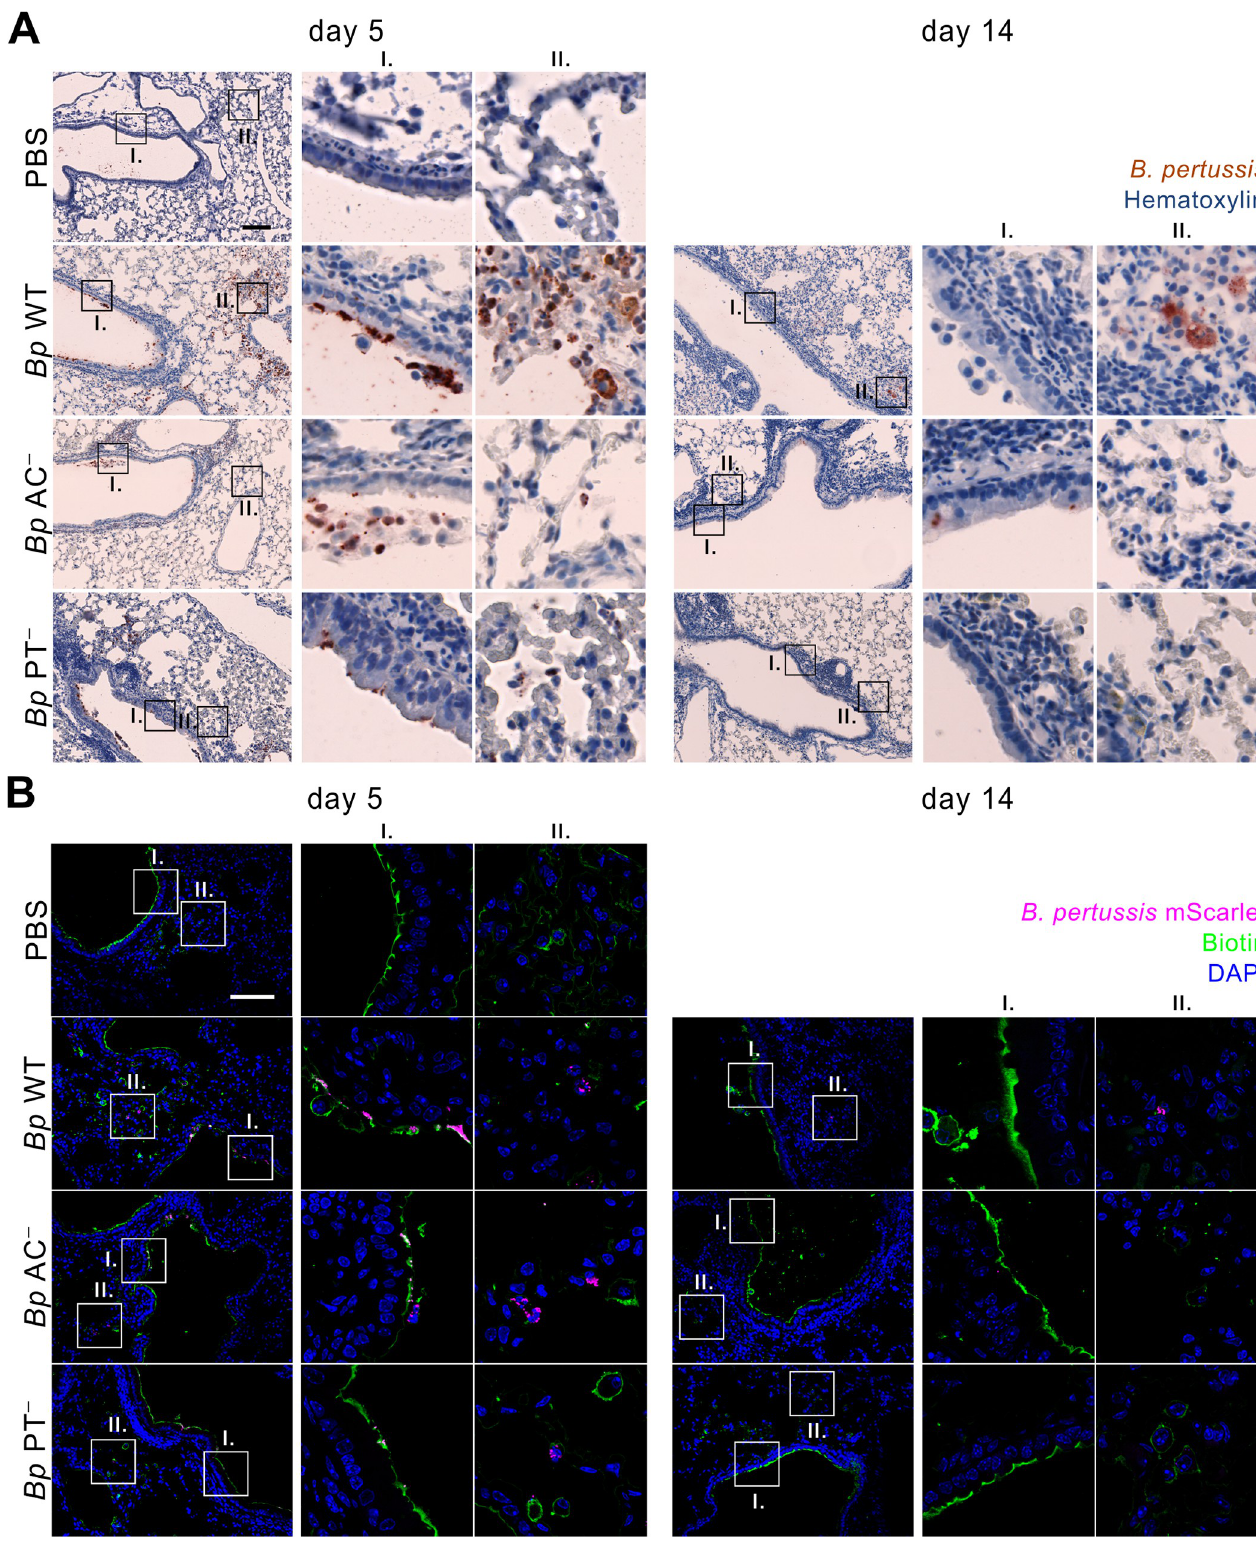
Fig 2. Enhanced Bp PT − accumulation in mLNs is not due to enhanced penetration of Bp PT − bacteria into lung parenchyma. (A) Immunohistochemistry of longitudinal lung sections from infected mice on day 5 (left panel) and day 14 (right panel) after intranasal administration of PBS (control) or 8 × 10 5 CFU of